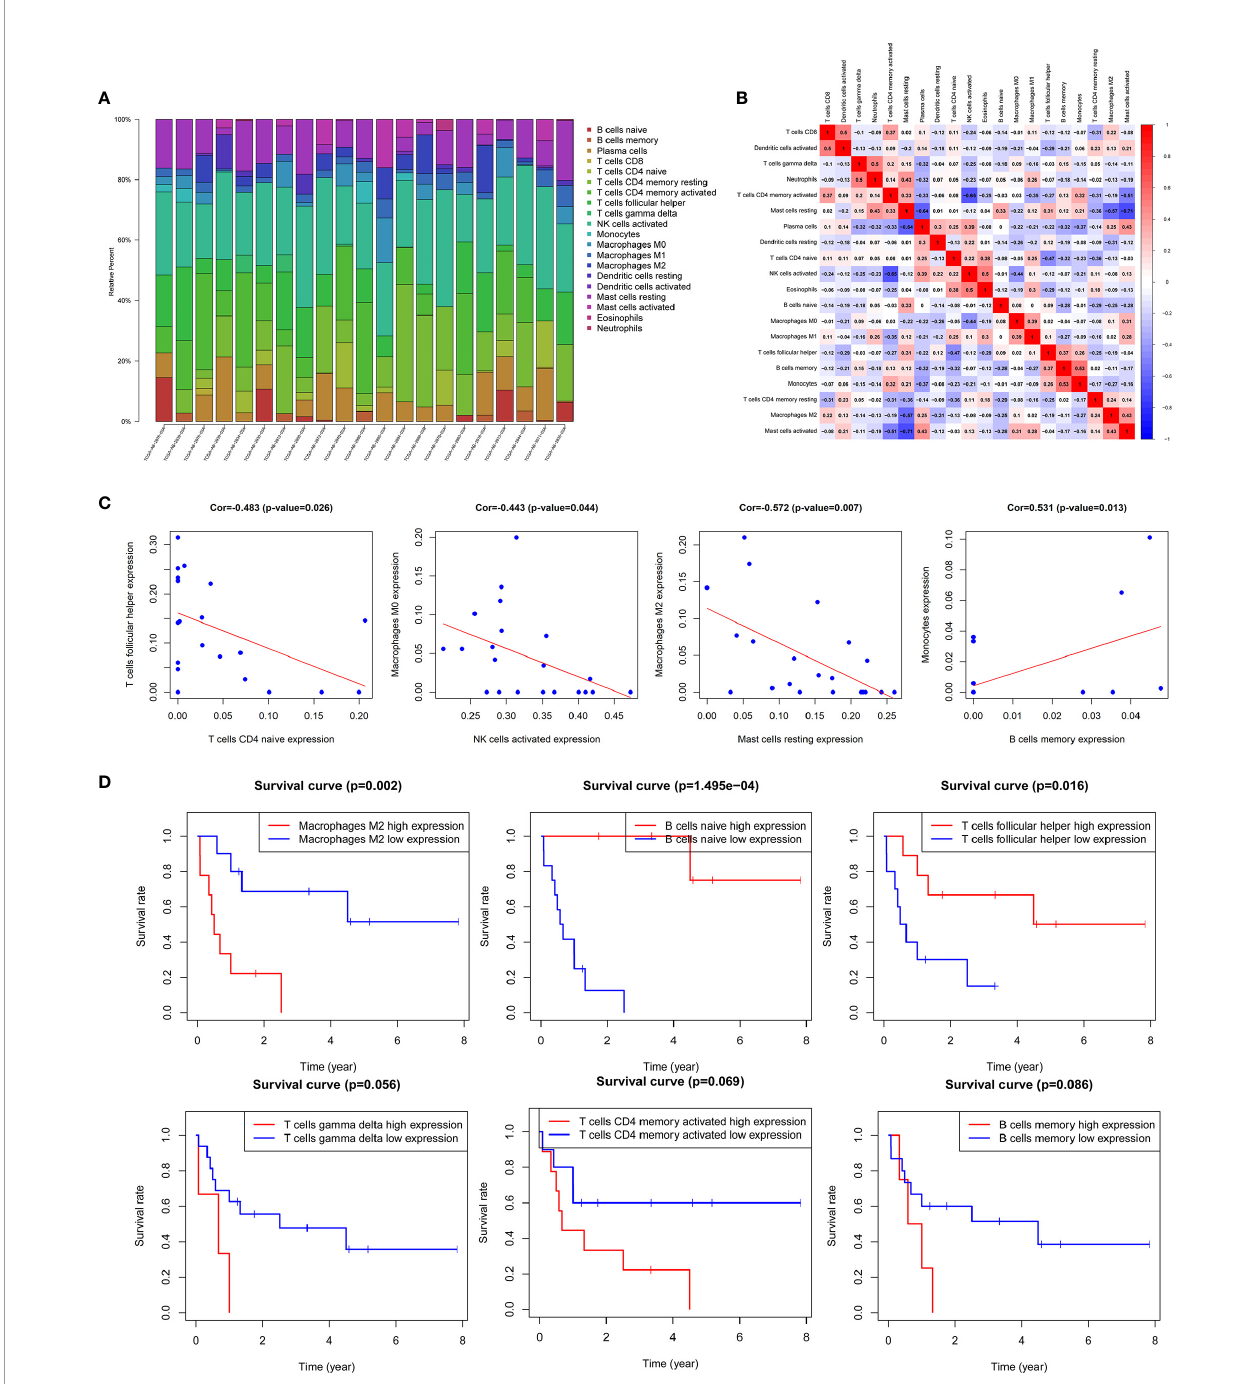
FIGURE 7 | Correlation analysis of TME immune cells and prognosis. (A) Histogram of the in fi ltration proportion of 22 types of immune cells between different samples. (B) Correlation heat map between immune cells. (C) Plots of correlation between immune cells: memory B cells and monocytes (P = 0.013) was signi fi cantly positively correlated; there was a signi fi cant negative correlation between resting mast cells and M2 macrophages (P = 0.007), activated NK cells and M0 macrophages (P = 0.044), naive CD4 memory T cells and helper follicular T cells (P = 0.026). (D) Survival curves of TME immune cell: the survival rate of AML patients with high proportion of M2 macrophages in fi ltration was signi fi cantly reduced (P = 0.002), patients with low proportion of naive B cells (P <0.001) and helper follicular T cells (P = 0.016) had decreased survival rate. In addition, the increase in the ratio of gd T cells, activated CD4 memory T cells and memory B cells also predicted the adverse outcome of AML, with no statistically signi fi cant